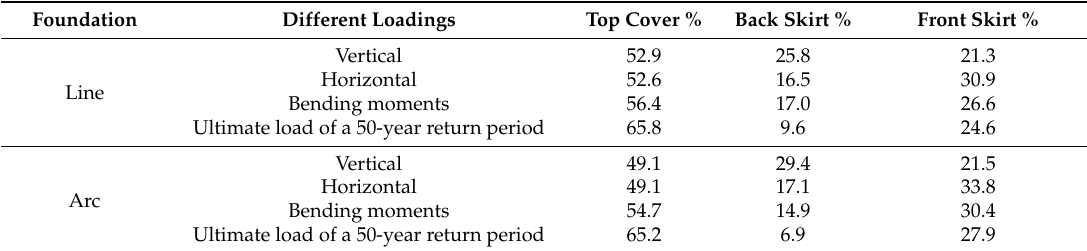
Table 3. Bearing proportions of different parts of the